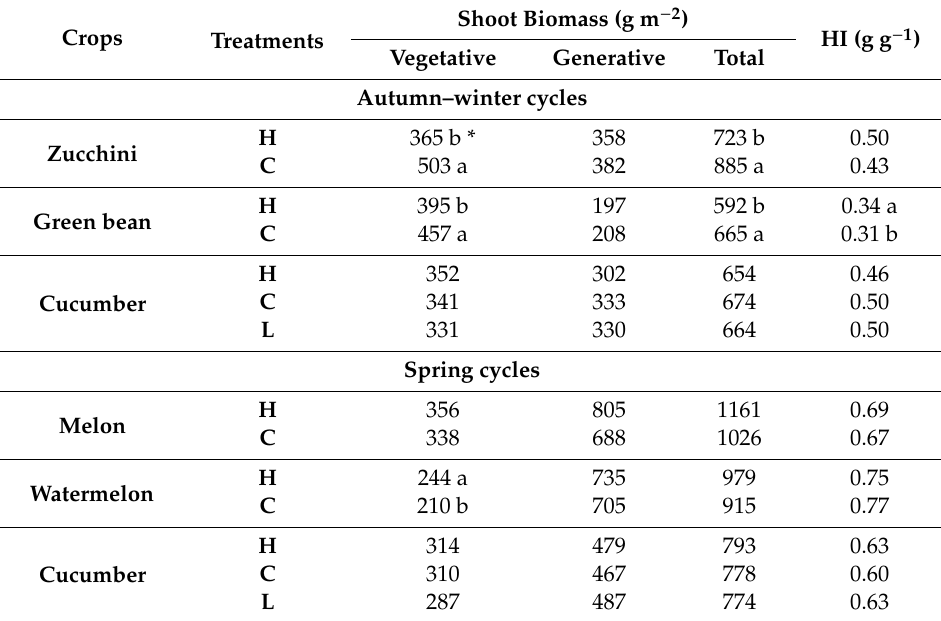
Table 4. Vegetative, generative and total shoot biomass, and crop harvest index (HI) of autumn–winter and spring cycles of greenhouse vegetable crops under high (H), conventional (C) and low (L) soil water availability treatments.